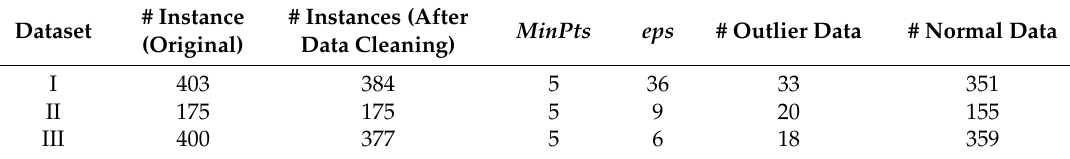
Figure 2. Optimal eps value and outliers are presented respectively for each dataset I ( a , b ); dataset II ( c , d ) and dataset III ( e , f ). Table 4. The result of DBSCAN-based outlier